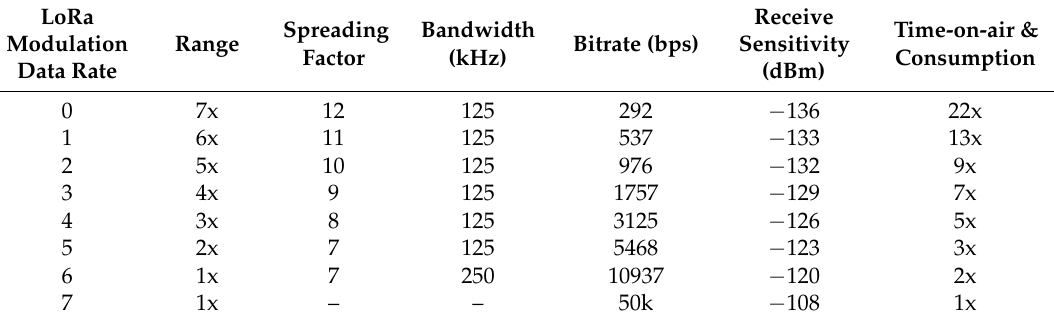
Table 4. Data Rate and Spreading Factor vs Bitrate and